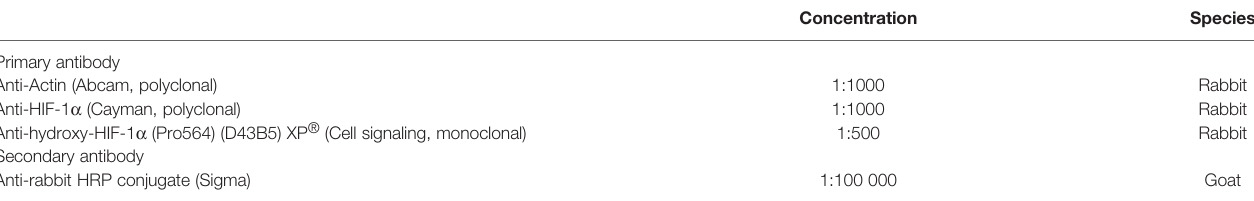
TABLE 2 | Antibodies used for standard Western